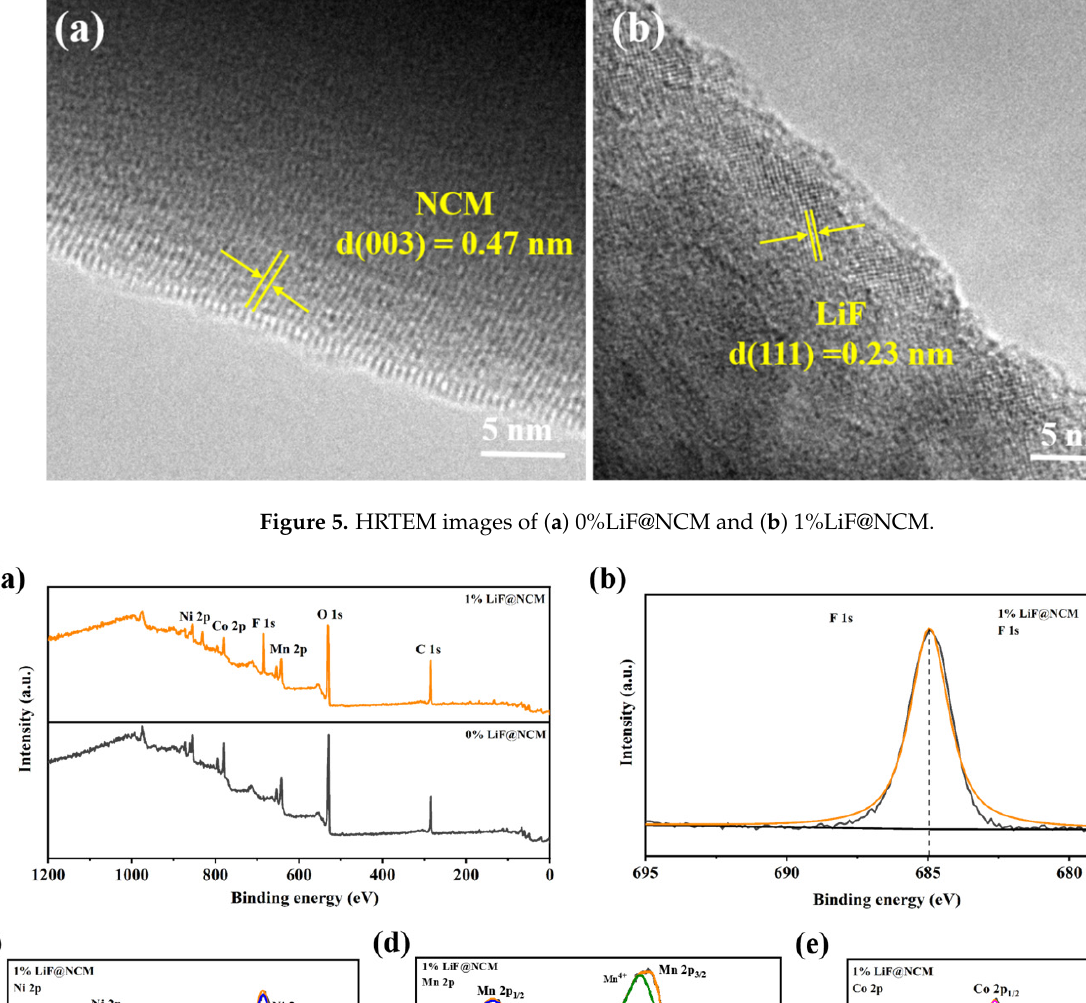
Figure 5. HRTEM images of ( a ) 0%LiF@NCM and ( b ) 1%LiF@NCM.